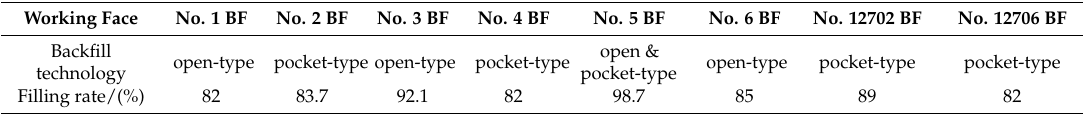
Table 1. The details of SCM backfilling in the Taoyi Coal